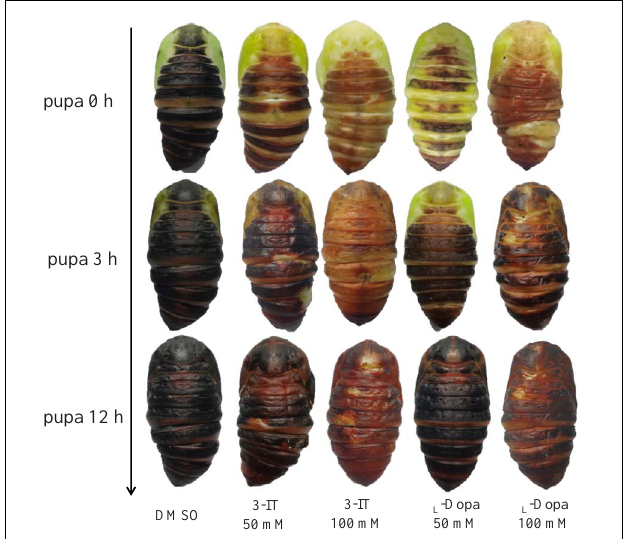
FIGURE 7 | Color changes under different titers of 3-IT and L -DOPA during 12 h.